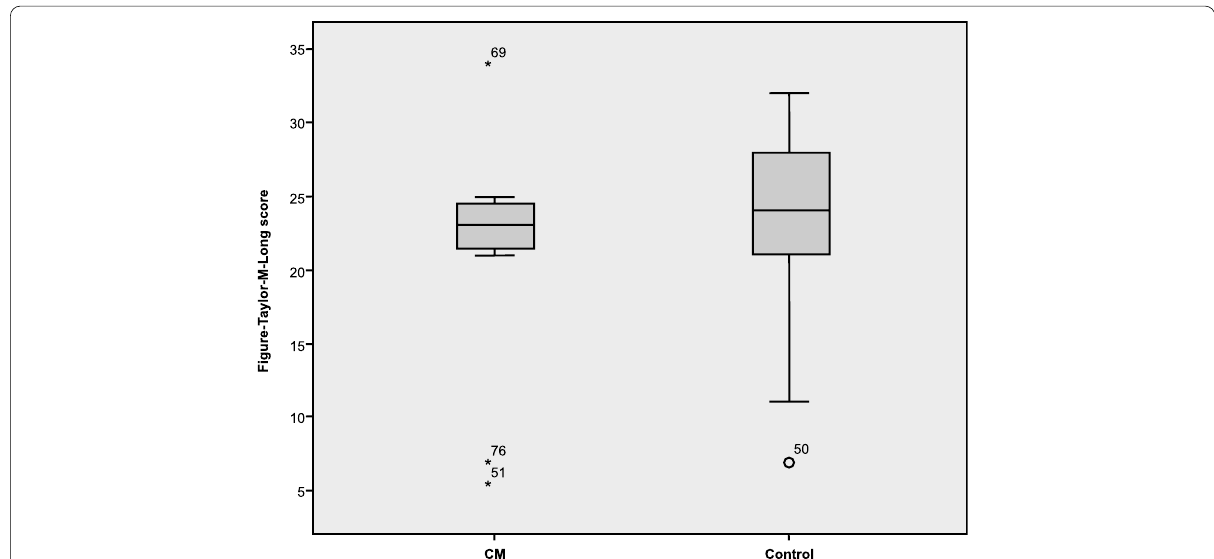
Fig. 6 Results of the assessment of the Taylor memory task in the subgroups of patients with CM and normal mood 3 months after preventive treatment and of control subjects with normal mood. Figure‑Taylor‑M‑Long: Taylor Figure test, memory task (longitudinal); CM, chronic migraine